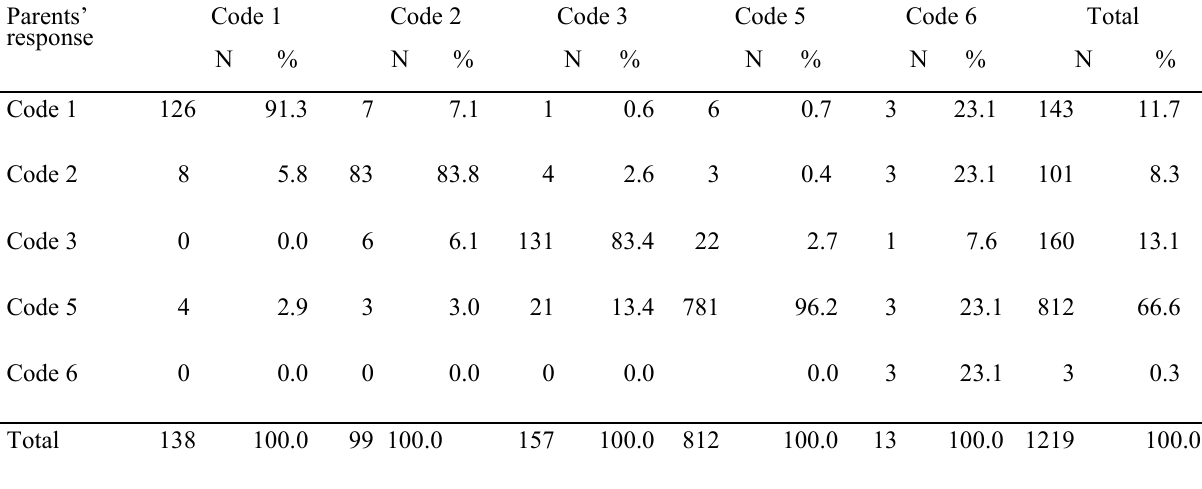
Table 3 Agreement between parents' and adolescents' responses about mother's occupation